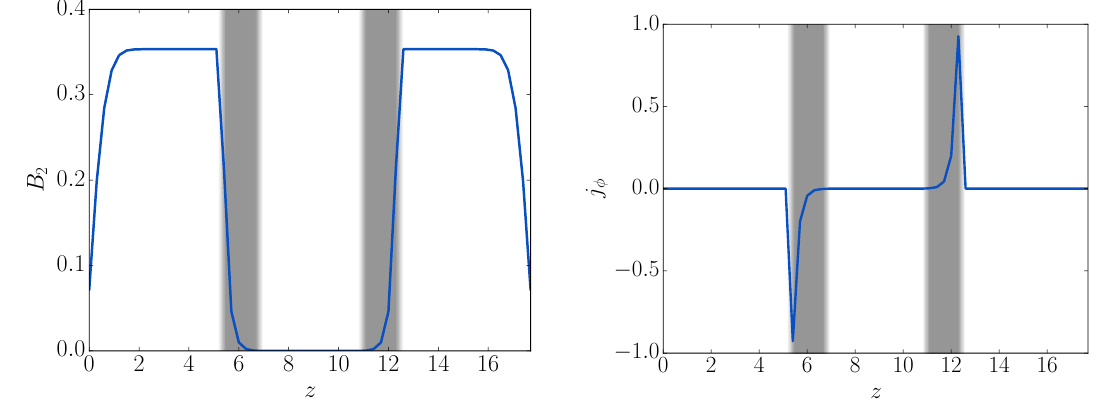
Figure 3 . The stationary magnetic (cid:12)eld in a typical simulation, after the current is turned on (left). The grey lines represent the superconducting barriers. The corresponding Higgs current (right). q = 0 : 3, (cid:17) = 4, d = 1 :